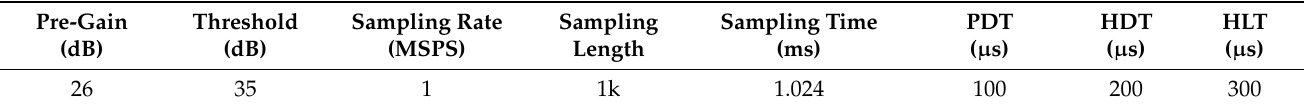
Table 2. Parameters setting of acoustic emission acquisition.